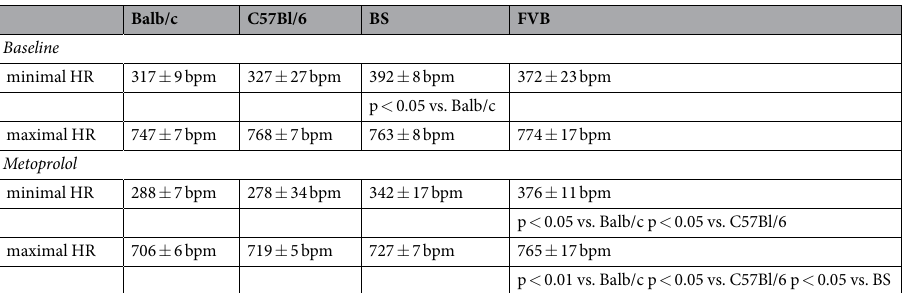
Table 1. Heart rate under baseline conditions and under β -adrenergic blockade. Minimal and maximal naturally occurring HRs per group under baseline conditions and under chronic administration of metoprolol. Values were calculated from 96 hours of ECG recordings. Data is given as mean ± SEM. Multiple comparisons were calculated using one-way ANOVA followed by Newman-Keuls post-hoc test. Balb/c n = 6, C57Bl/6 n = 6, BS n = 6, FVB n =